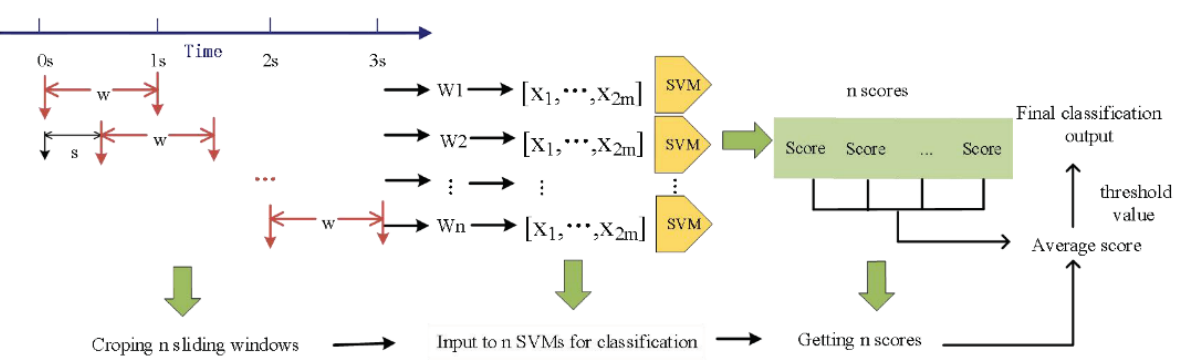
Figure 6. Schematic diagram of the AS decision algorithm.